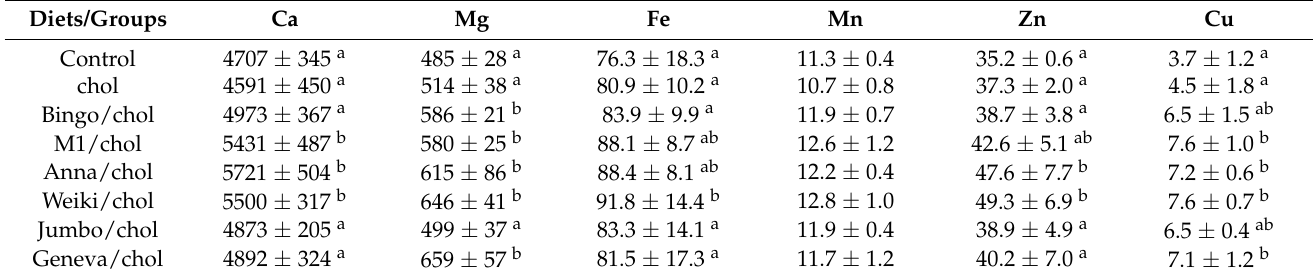
Table 2. Contents of mineral elements in the diets for rats (mg · kg − 1 DM); mean ± SD. Diets/Groups